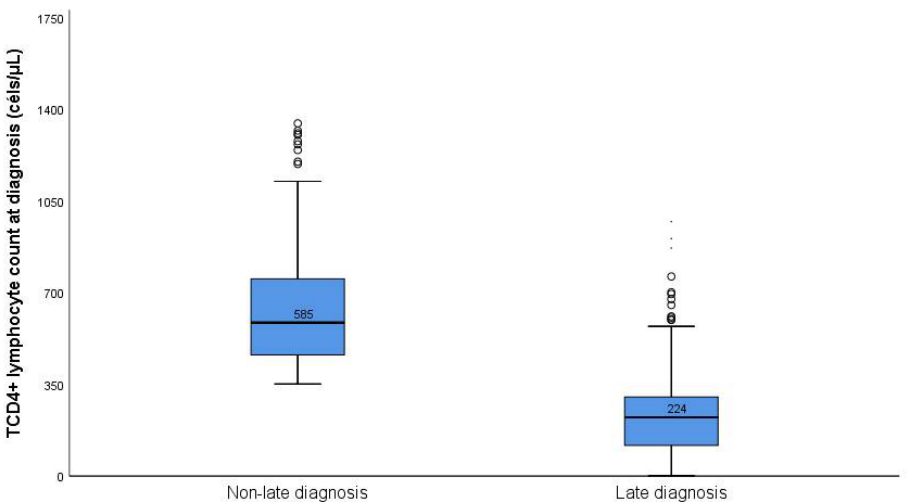
Figure 2. Lymphocyte count at the time of diagnosis.